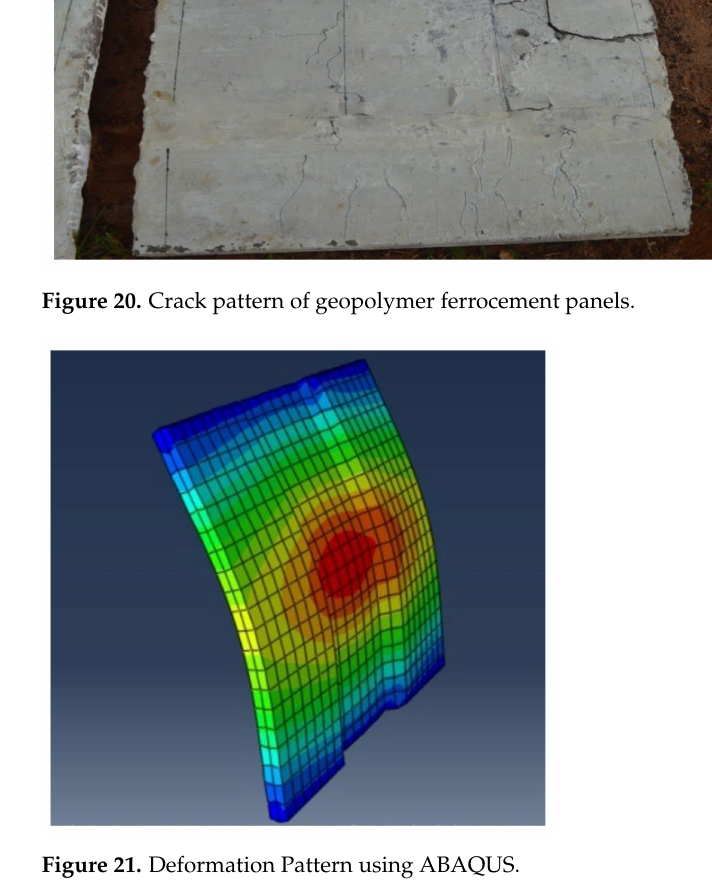
Figure 21. Deformation Pattern using